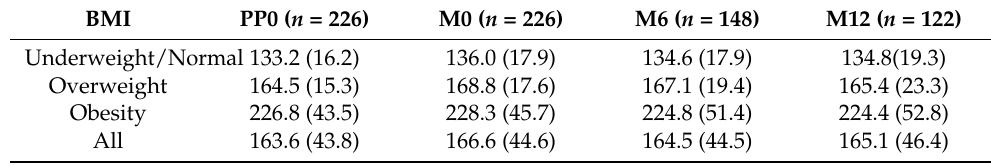
Table 3. Mean (standard deviation) weights over time, by BMI category.